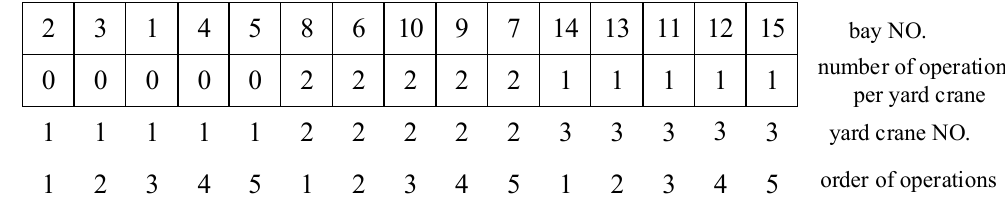
Figure 6. Chromosome coding.